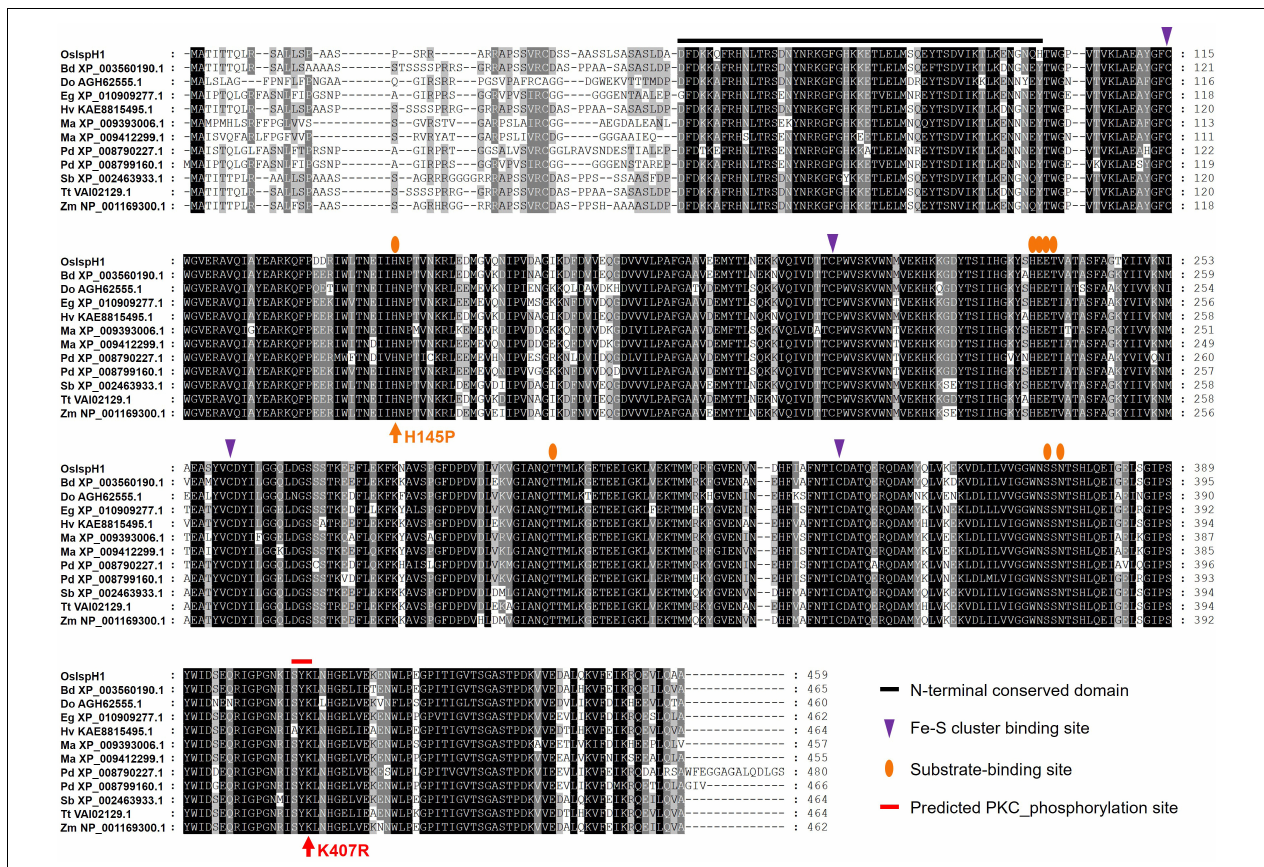
FIGURE 3 | Amino acid sequence alignment among monocot plant IspHs. Supplementary Table 2 contains more information on IspH